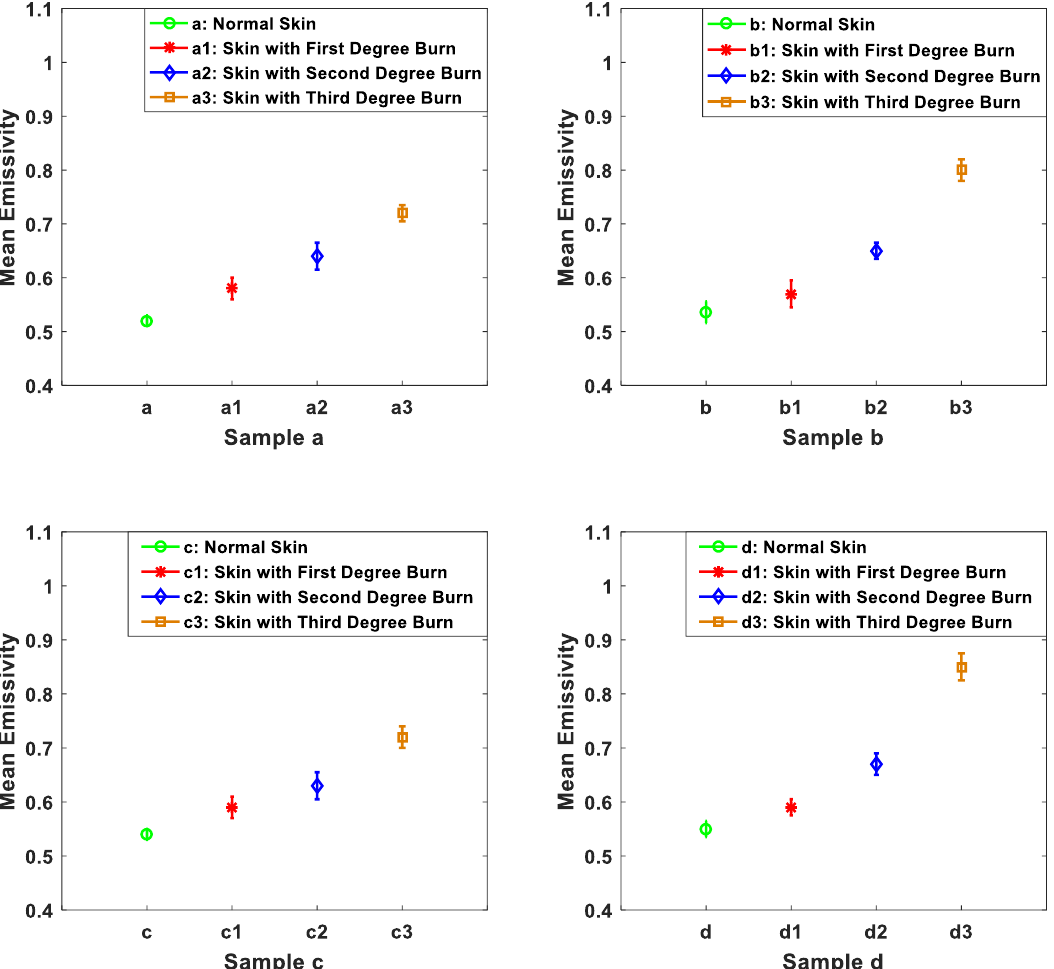
Table 2. However, the mean emissivity values for the burn-damaged skin are di ff erent from sample to sample and this is due to the resistivity and the conductivity of the skin, as that varies from animal to animal [46–48]. The measurements presented in Figure 9 confirm that radiometry can distinguish between di ff erent burn depths as it provides di ff erent mean emissivity values after each application of localized heat treatment.